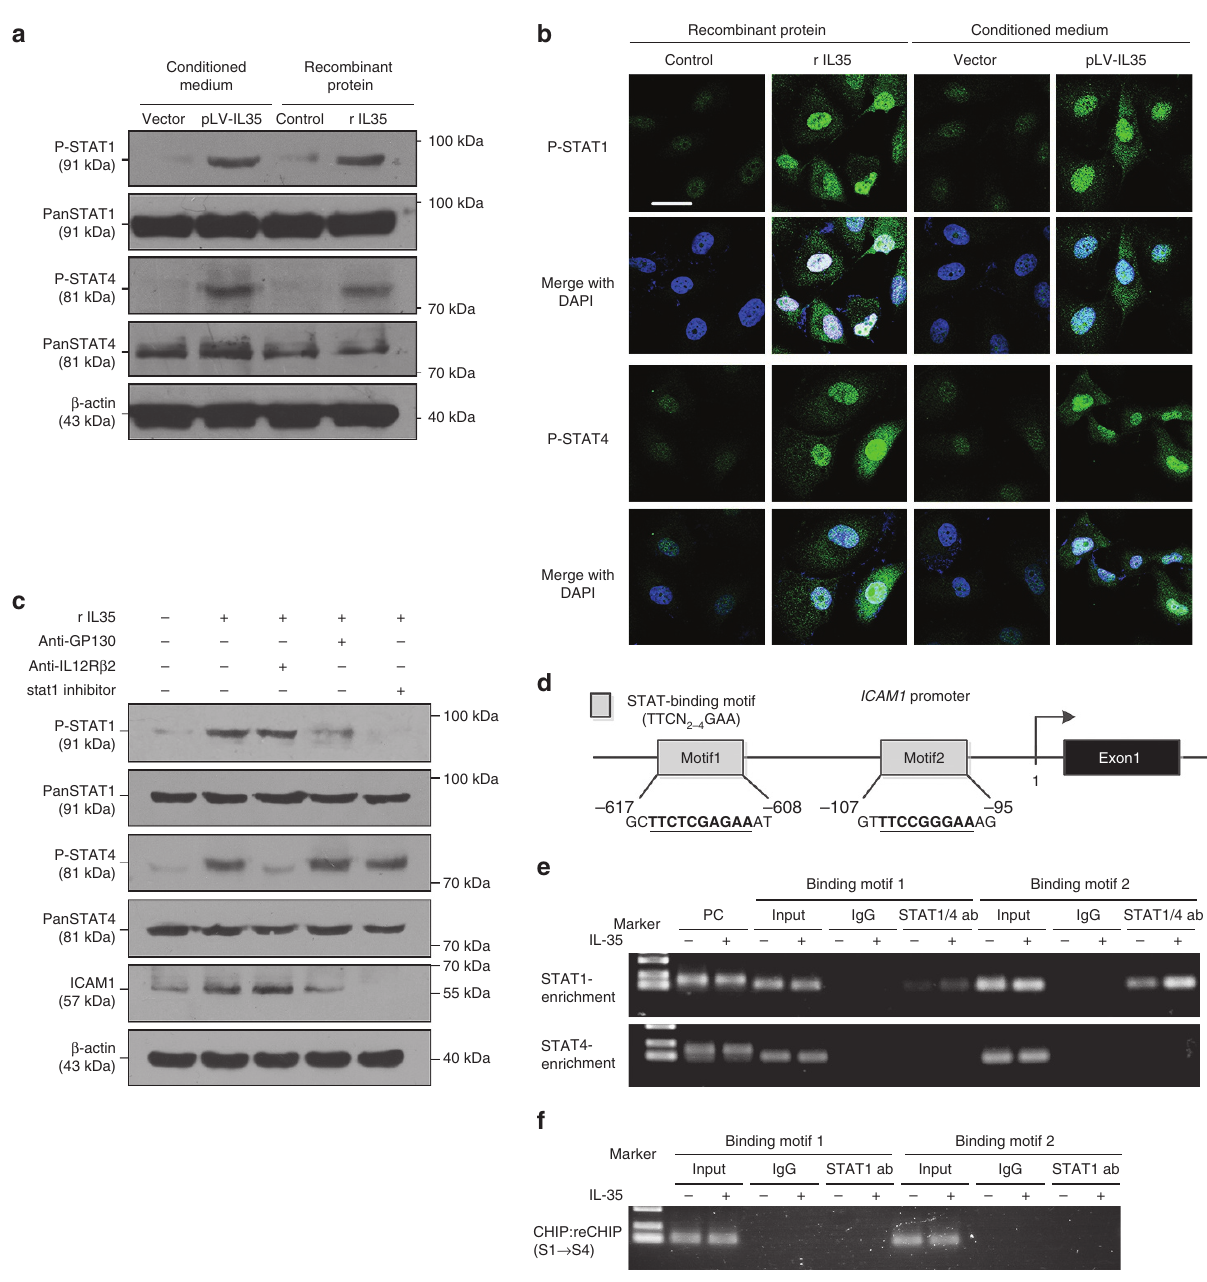
Figure 6 | IL-35 regulates ICAM1 expression via phosphorylated STAT1 homodimer. ( a ) PANC-1 cells treated with conditioned medium or recombinant IL-35 (rIL-35) for 30min, probed with antibodies to phosphorylated (-p) STAT1 and STAT4. ( b ) Representative immunofluorescence images demonstrate the translocation process of p-STAT1 and p-STAT4 to the nucleus in PANC-1 cells incubated with conditioned medium or recombinant IL-35 for 1h. Scale bars, 30 m m. ( c ) PANC-1 cells were pretreated with or without the STAT1 inhibitor fludarabine (2 m gml (cid:2) 1 ), anti-GP130 antibody (100ngml (cid:2) 1 ) and anti-IL12R b 2 antibody (2 m gml (cid:2) 1 ) for 30min, then cultured with recombinant IL-35 (100ngml (cid:2) 1 ) for 16h and subjected to western blotting assays. ( d ) Human ICAM1 promoter; two of the identified STAT-binding motifs were investigated. ( e ) CHIP analysis of PANC-1 cells pretreated with or without IL-35 (100ngml (cid:2) 1 ) for 90min. Chromatin was immunoprecipitated with anti-STAT1 or anti-STAT4 antibodies and then subjected to RT–PCR analysis. ( f ) CHIP: reCHIP analysis of PANC-1 cells prepared as in e ; Chromatin was first immunoprecipitated with anti-STAT1 antibody and then immunoprecipitated again with anti-STAT4 (S1 -